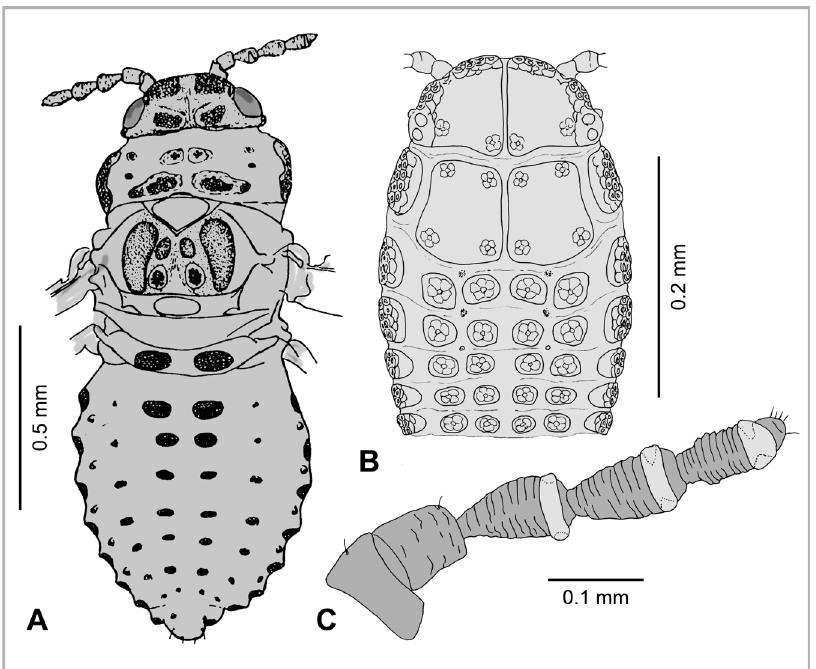
Fig. 71. Adelges (Gilletteella) cooleyi (Gillette, 1907). A . Gallicola (after Carter 1971, redrawn from Heie 2004). B . Neosistens (after Schneider-Orelli 1947). C . Antenna of gallicola (after Annand 1928,